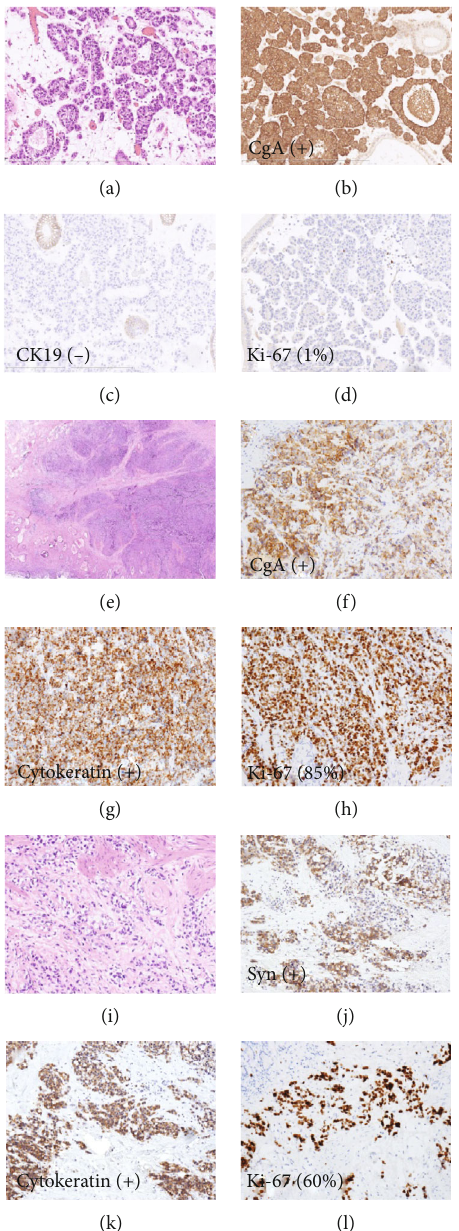
Figure 2: H&E staining and IHC studies of GB-NENs. (a) H&E staining of NET G1 (case 13). (b – d) IHC staining of NET G1 (case 13). (e) H&E staining of GB-MiNENs (case 2). (f – h) IHC staining of GB-MiNENs (case 2). (i) H&E staining of amphicrine carcinoma (case 9). (j – l) IHC staining of amphicrine carcinoma (case